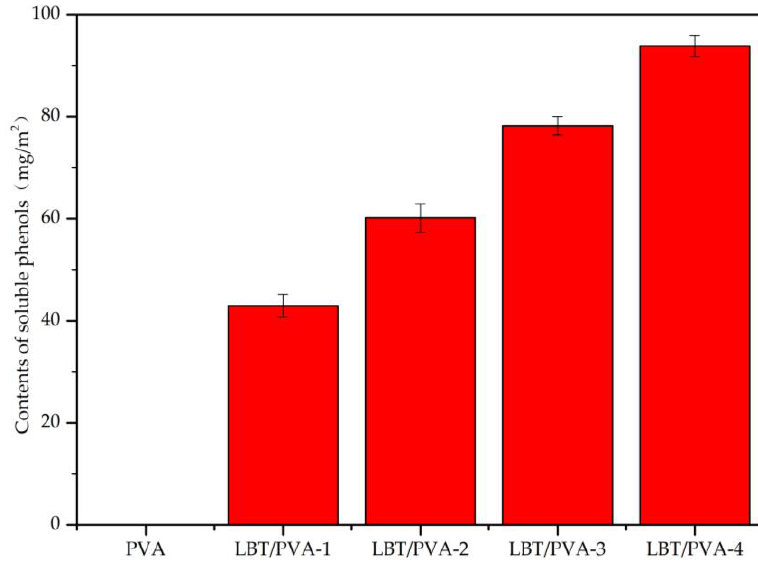
Figure 3. Contents of soluble phenols in the composite LBT/PVA membranes.